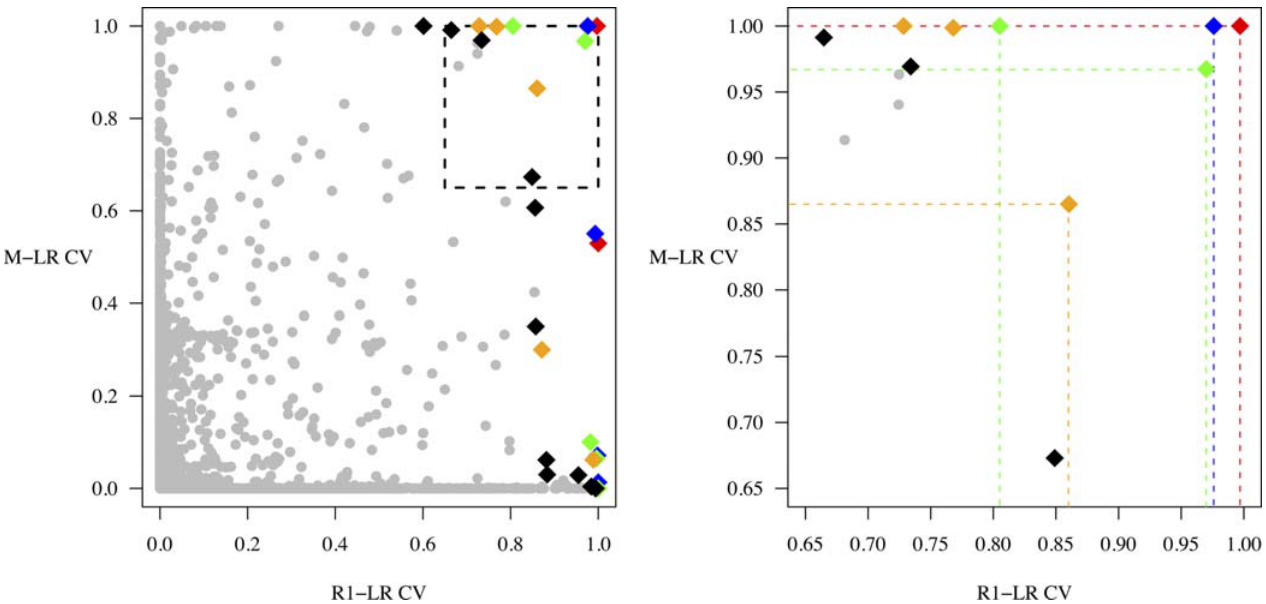
Figure 3. Two-way Pareto Front Analysis applied to CVs from the R1–LR Dataset and the M–LR Dataset (Left) Shows the CVs for all comparable genes with the first five Pareto fronts highlighted (red, first PF; blue, second PF; green, third PF; gold, fourth PF; black, fifth PF). (Right) Shows a magnification of the dashed box in the left panel. Here the red gene is said to dominate all other genes because, although it has an M– LR CV equal to that of several other genes, it has the highest R1–LR CV. Thus it lies on the first PF. In the same way, the blue gene dominates all genes except the red gene and thus lies on the second PF. It is not possible to choose between the two green genes because they each have larger CVs in one of the two experiments. They, therefore, lie on the same (third) PF. The highlighted yellow gene does have a larger CV in the R1–LR dataset than the green gene on the left but it falls on a lower PF because it is completely dominated by the green gene on the right.